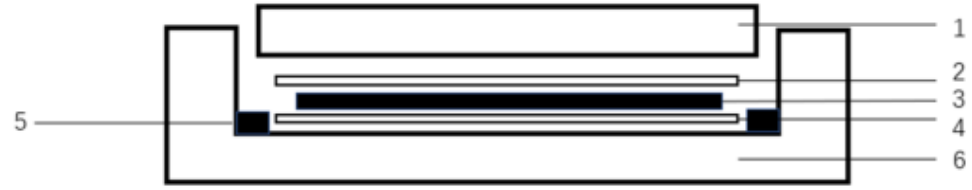
Figure 4. Hot pressing diagram. 1, upper cover plate; 2, polyimide film; 3, prefabricated parts; 4, polyimide film; 5, filler piece; 6, lower Figure 3. Composite laminate structure diagram. ( a ) P0F6 , pure PPS film; ( b ) P2F4 , the ratio of film to particle is 2:1; ( c ) P4F2 , the ratio of film to particle is 1:2; ( d ) P6F0 , pure PPS particles.